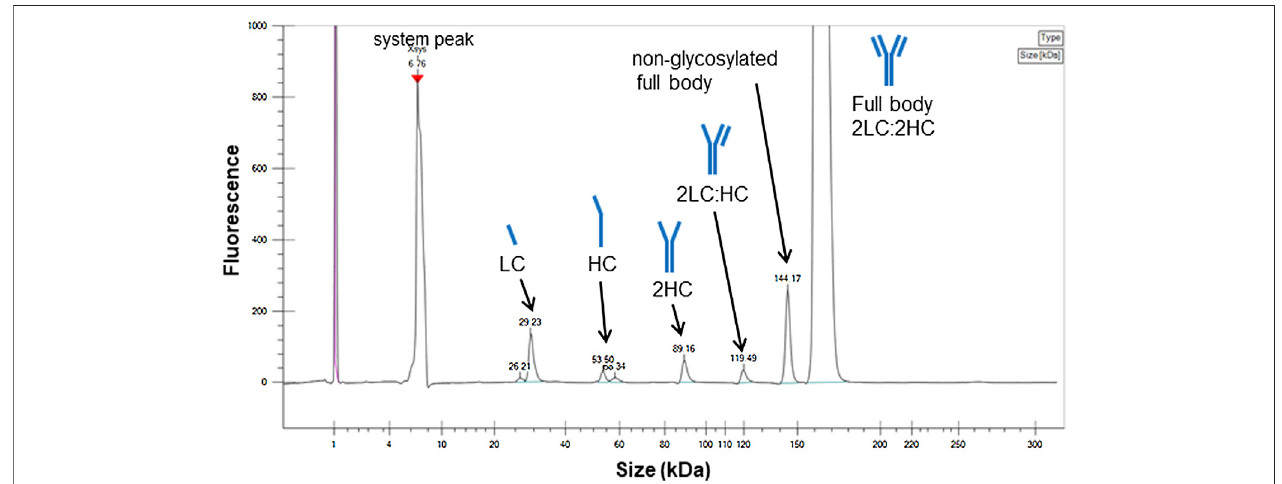
Frontiers in Molecular Biosciences |